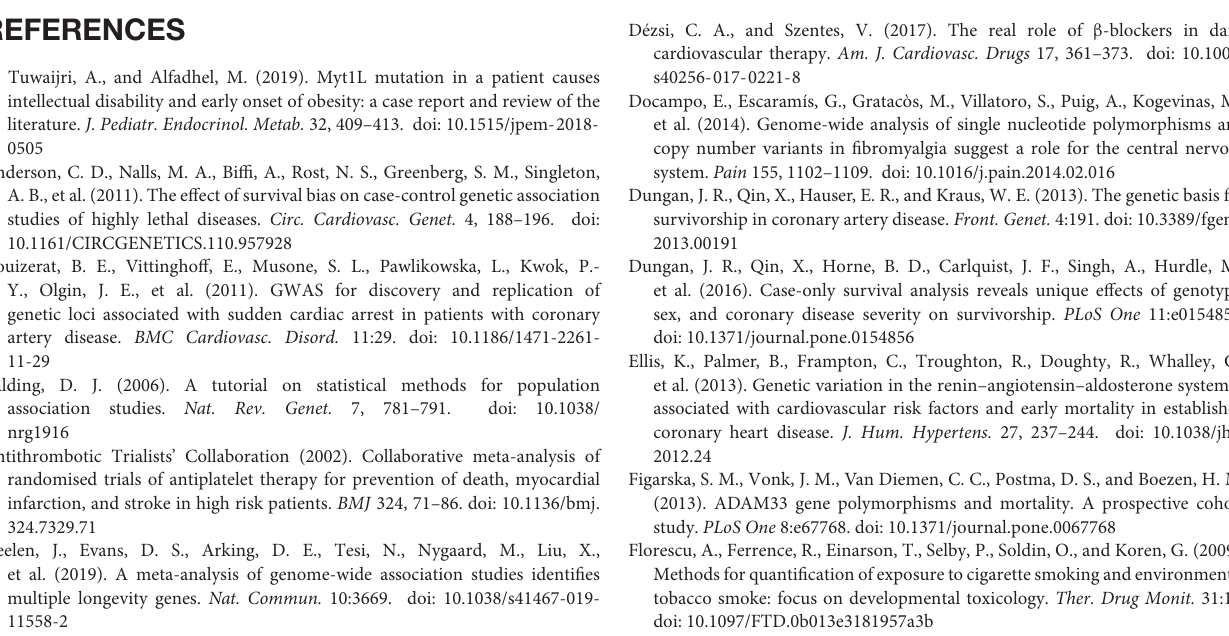
Supplementary Figure 2 | SNP effect size congruence between discovery and replication datasets. Supplementary Table 1 | Base model hazard of all-cause mortality among cad cases for discovery-screened SNPs. Less frequent (minor) allele bolded. Bold